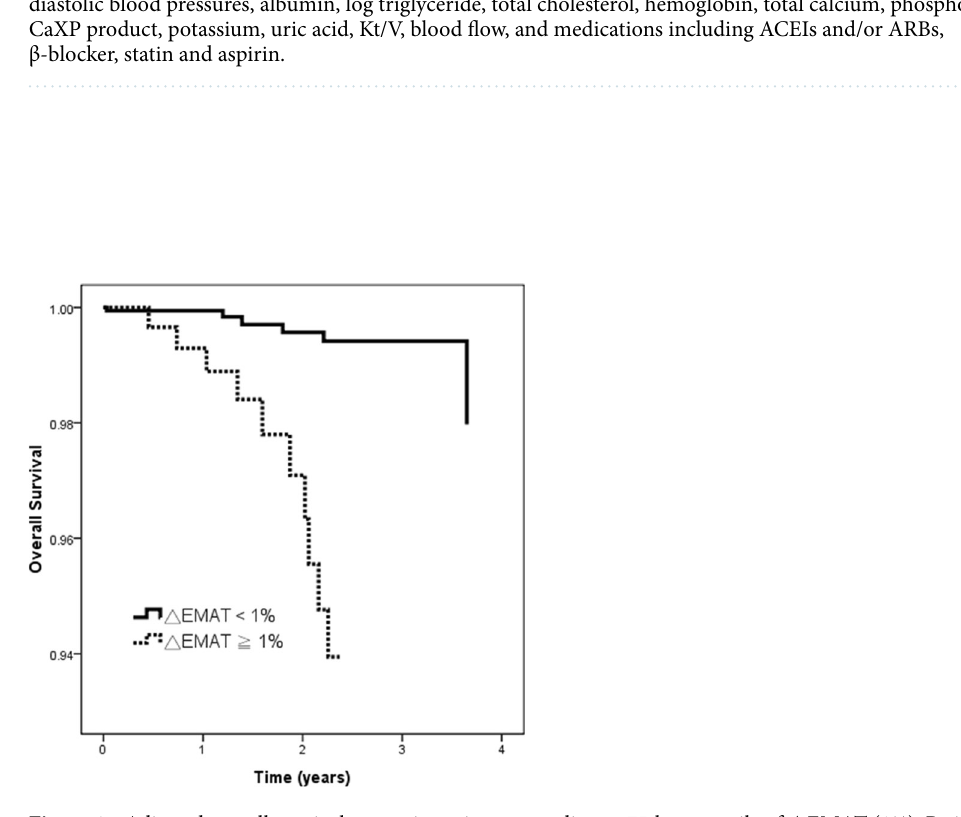
Figure 1. Adjusted overall survival curves in patients according to 75th percentile of △ EMAT (1%). Patients with △ EMAT ≧ 1% had a worse overall survival than those with △ EMAT < 1% ( p =